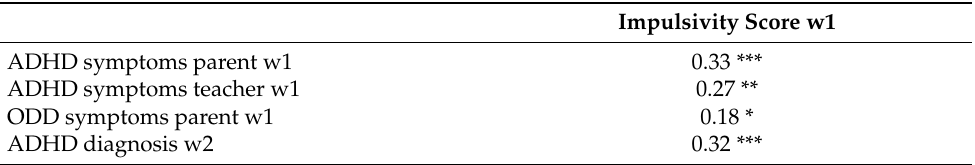
Table 4. Concurrent and longitudinal associations between impulsivity and the ADHD and ODD scores in Study